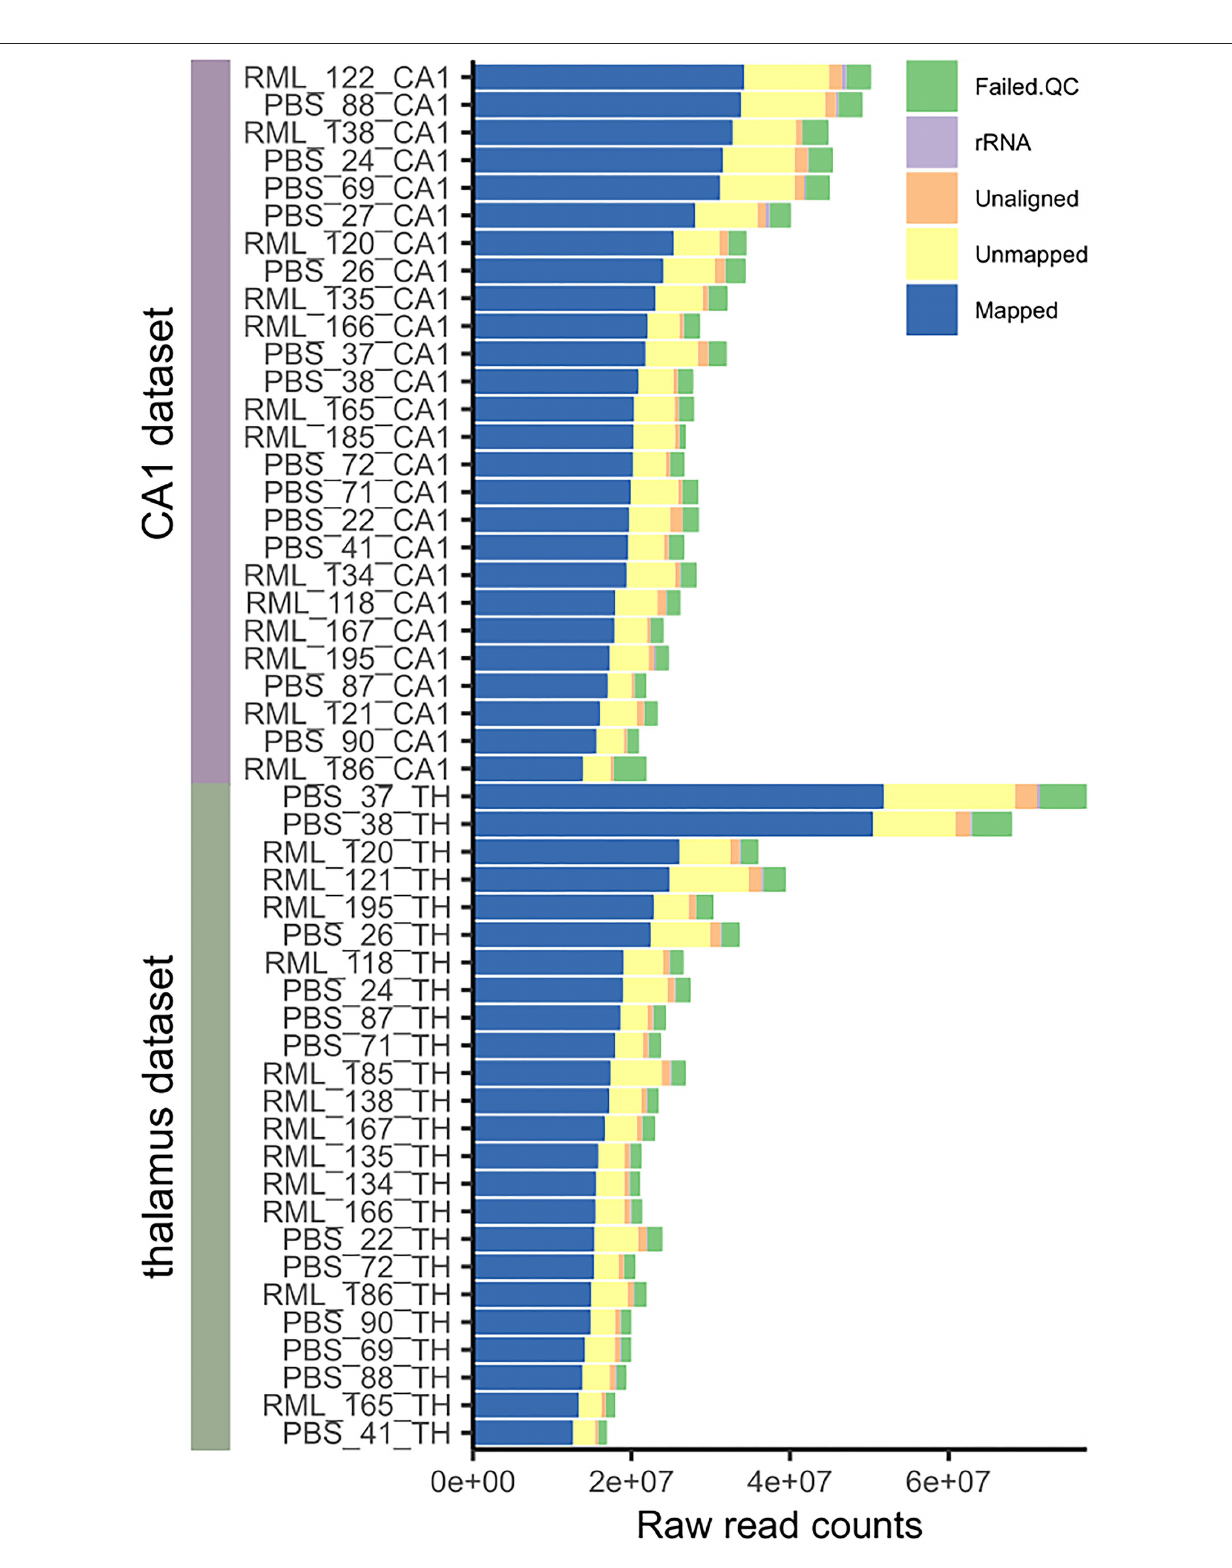
Frontiers in Neuroscience | www.frontiersin.org